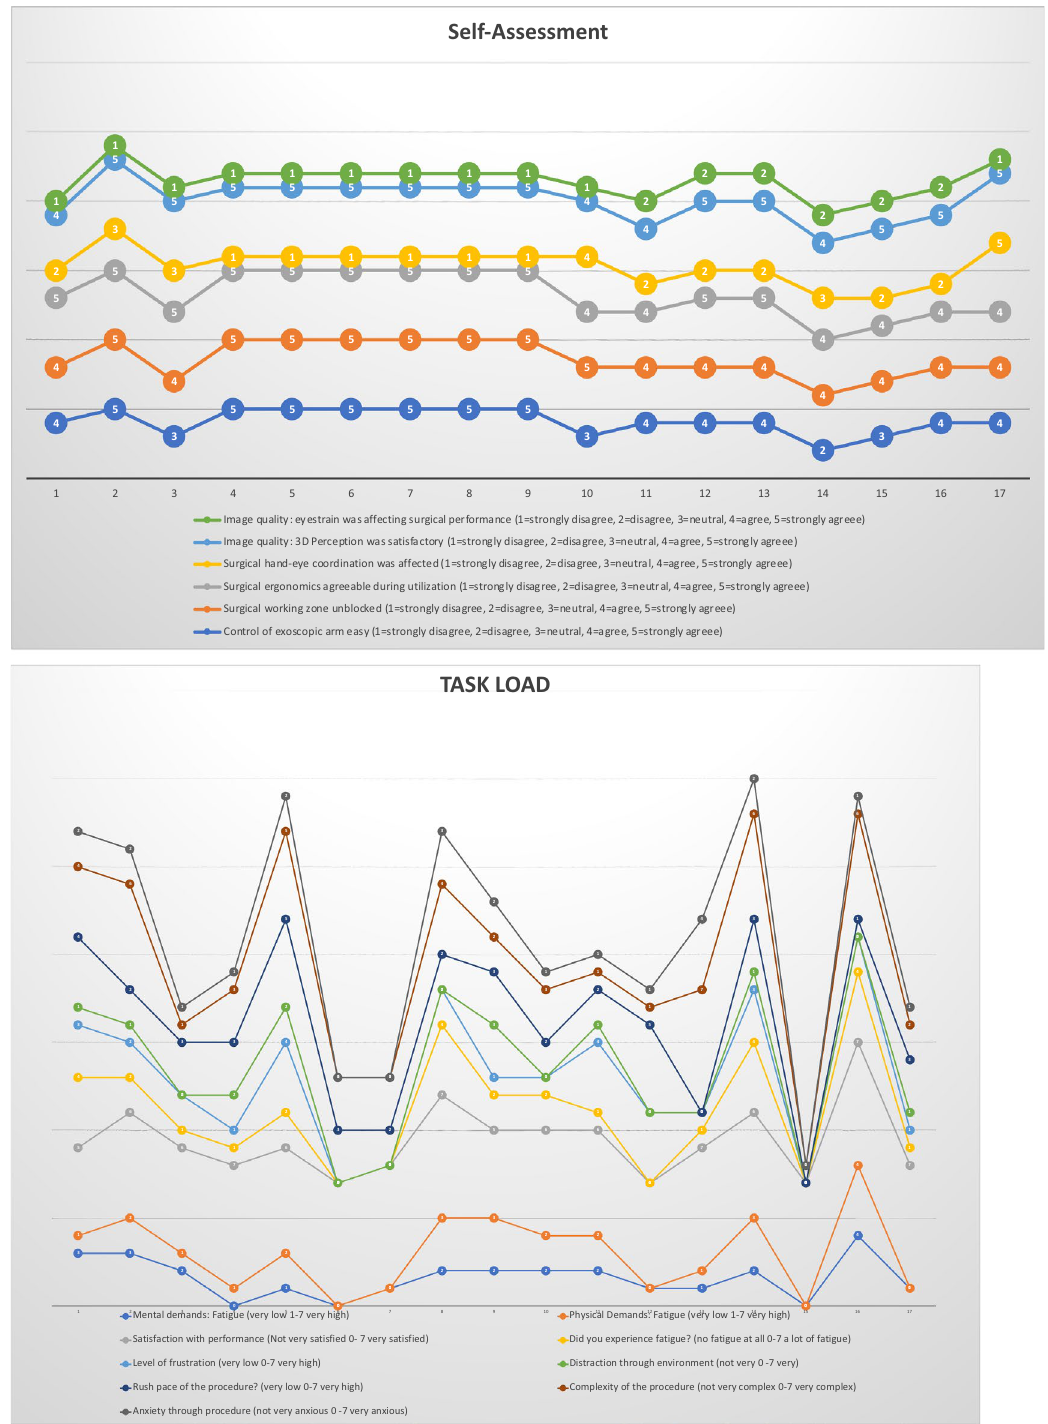
Figure 9. Results of surgeons’ questionnaires classified in the categories self-assessment, task load and utilization and image